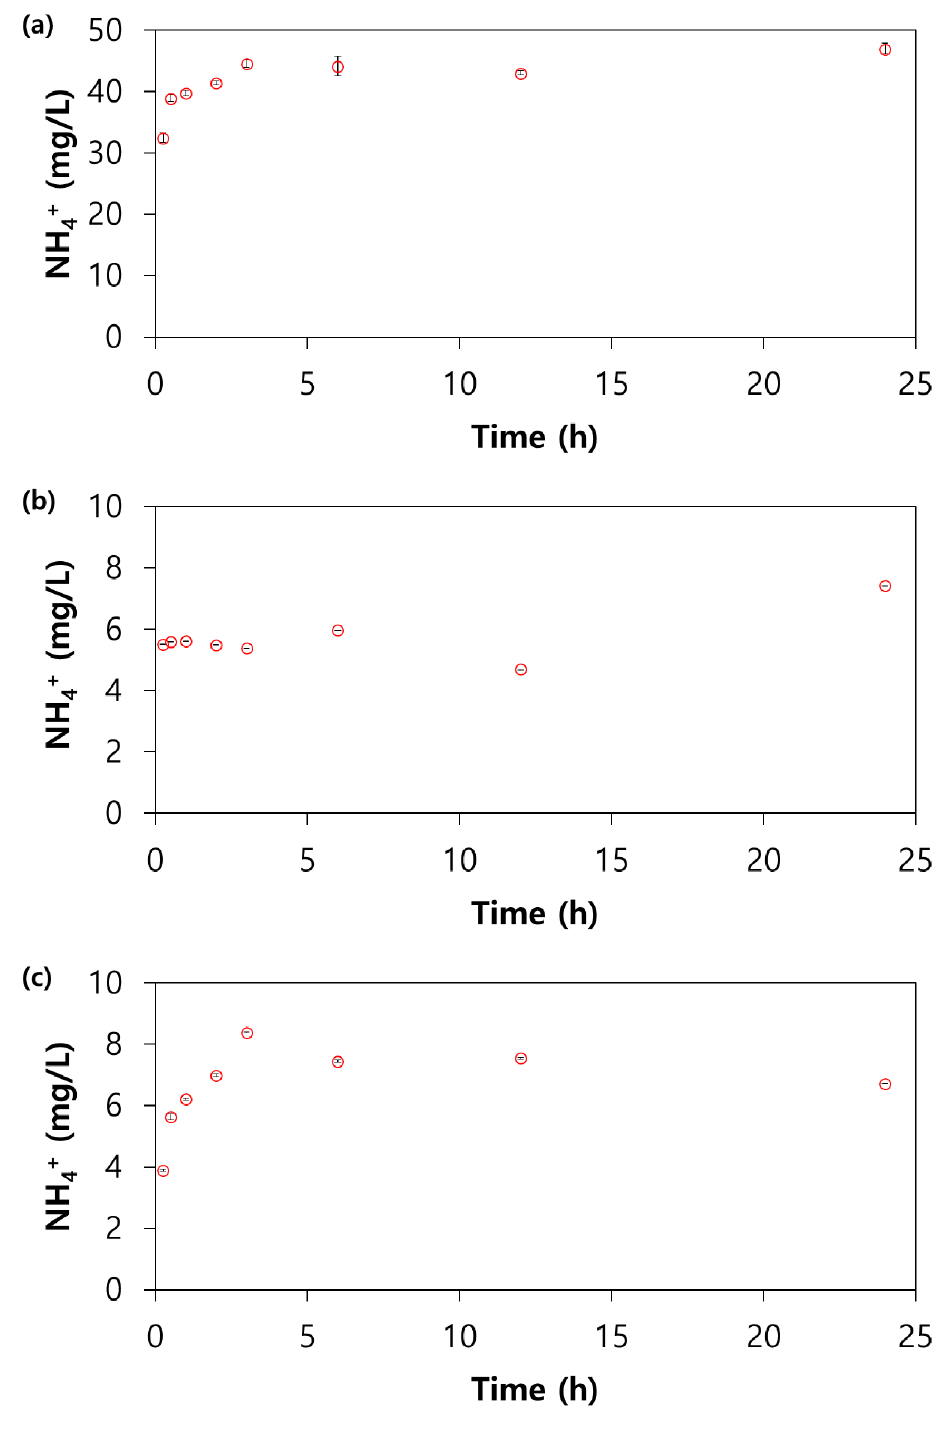
Figure 2. Reaction time for NH 4 concentration eluted from thermo-chemically treated carcass product. ( a ) non-treated condition, ( b ) zeolite added after NH 4 elution from thermo-chemically treated carcass product over a 24 h period, and ( c ) thermo-chemically treated carcass and zeolite in the same solution. Zeolite can adsorb NH 4+ ions in aqueous solution through cation exchange by re- placing exchangeable cations adsorbed on the framework, formed from SiO 4 and AlO 4 tetrahedra of zeolite [31,32]. The anions adsorbed via cation exchange are loosely held together by electrostatic attraction, and they can diffuse into a solution after replacement by other anions [33]. Zeolite plays an important role in supplying NH 4 by reducing leaching